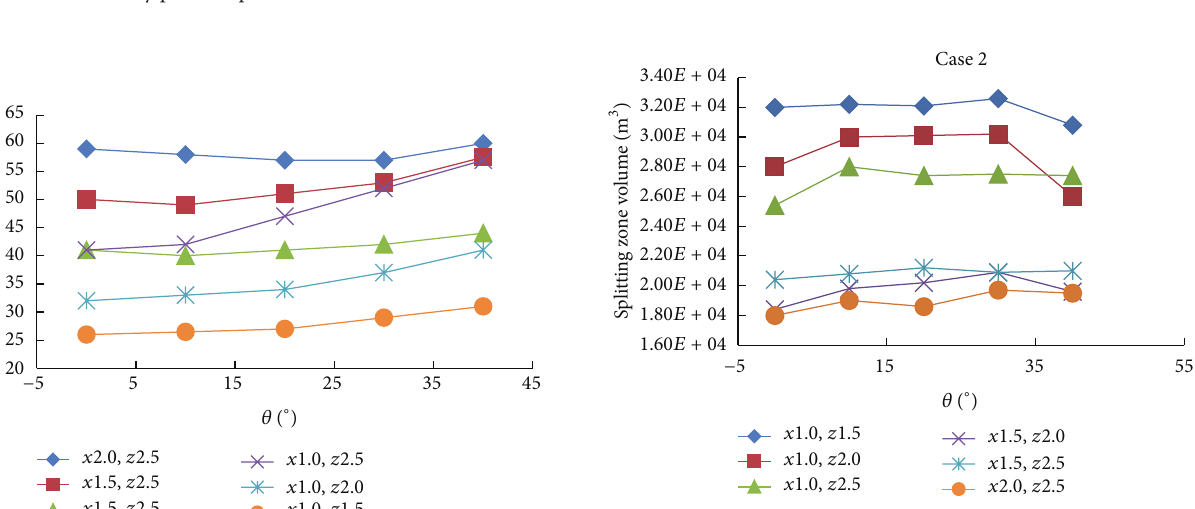
Figure 23: Key point displacement versus 𝜃 in case 1 .